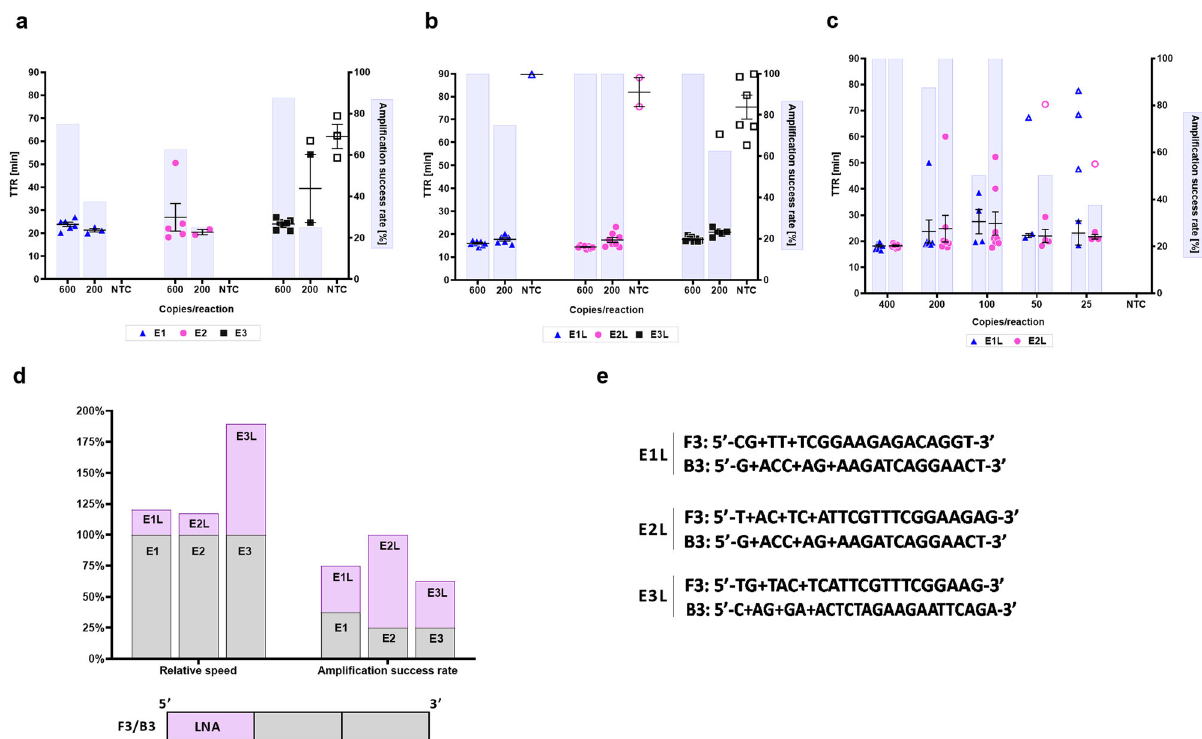
Fig. 1 Primer set screening for the detection of SARS-CoV-2 E gene. a Performance, measured as TTR, of the top three primer set candidates (E1, E2, E3) for SARS-CoV-2 E gene at the indicated number of synthetic SARS-CoV-2 RNA copies per reaction. b Comparison of E1, E2, and E3 primer sets containing LNA modi fi cations near the 5 ’ end of their F3/B3 outer primers, labeled as E1L, E2L, E3L. Reaction conditions are identical with a . c An extended comparison of limits of detection of sets E1L and E2L. d Ampli fi cation improvements obtained by LNA modi fi cations in all three primer set candidates displayed as changes in relative speed and higher ampli fi cation success rate. Based on data from a and b at 200 cp/rxn. Relative speed is mean TTR of base set divided by TTR of LNA-modi fi ed set. e Positions of LNA bases in sequences of F3/B3 outer primers in primer sets E1L, E2L, and E3L. Open symbols represent non- speci fi c products, whereas closed symbols are speci fi c as determined by melt curve analysis of ampli fi cation products. The highest time to reaction value on y-axis signi fi es the total duration of the reaction. Ampli fi cation success rate shows the number of samples that ampli fi ed over the course of the reaction. For NTC reactions, PCR-grade water was used as the input. All experiments were performed using “ NEB WarmStart ” reaction mix. “ + N ” signi fi es the presence of an LNA base. Error bars represent standard error of the mean. In all experiments, n = 8 technical replicates per group were used. TTR time to reaction, NTC no-template